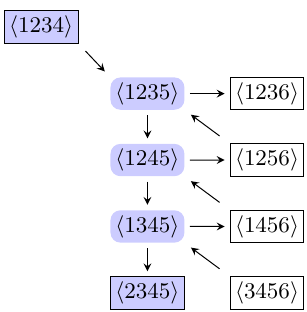
Figure 16. The cluster containing the poles of [12345] in Conf 6 ( P 3